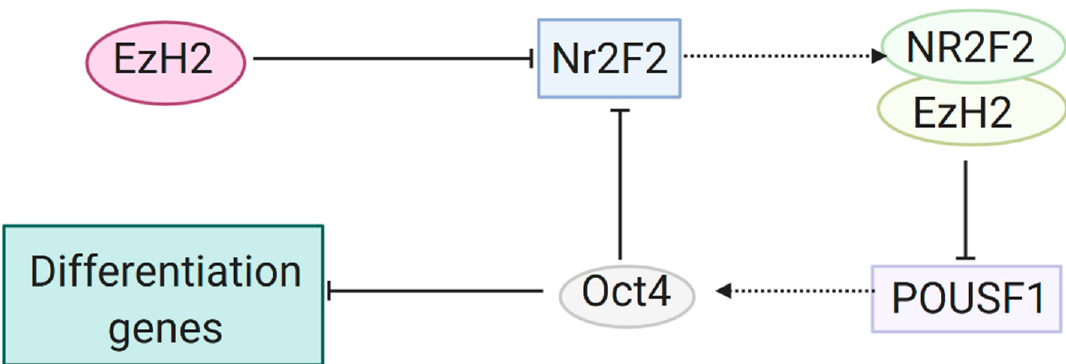
Figure 2. Maintenance of pluripotency in hESCs by EZH2 silencing of NR2F2. EZH2 silences the Nr2f2 gene from transcribing via the trimethylation of histone 3 at lysine 27. EZH2 also binds with the gene product NR2F2 to repress transcription of the Pou5f1 gene, which codes for OCT4. OCT4 prevents differentiation and maintains pluripotency of hESCs, and additionally acts to repress further transcription of Nr2f2 [68,69].